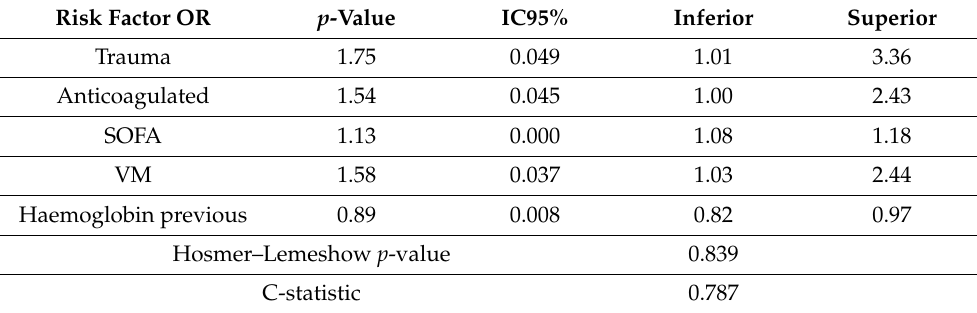
Table 6. Logistic regression to identify factors associated with the transfusion of blood